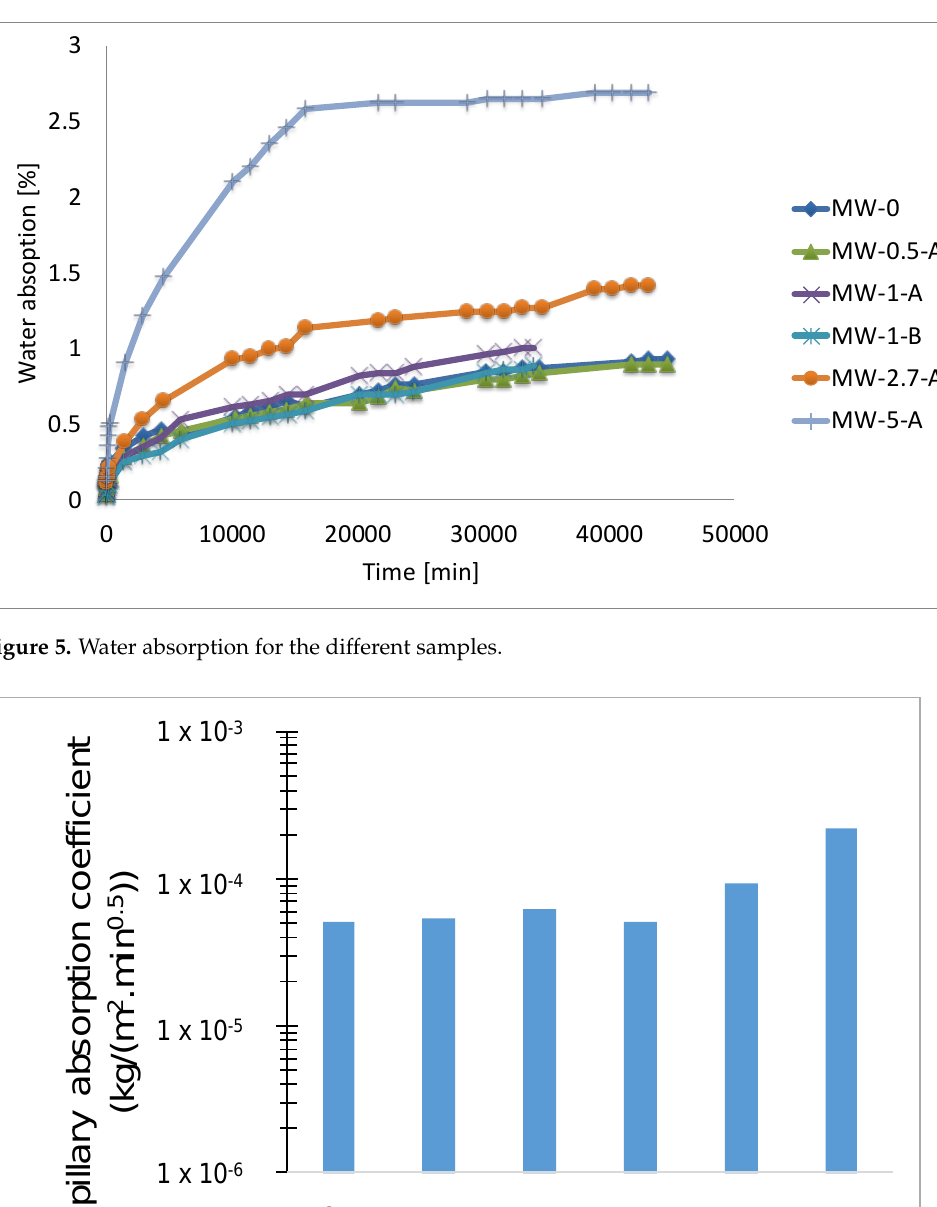
Figure 6. Capillary absorption coefficient for the different samples.